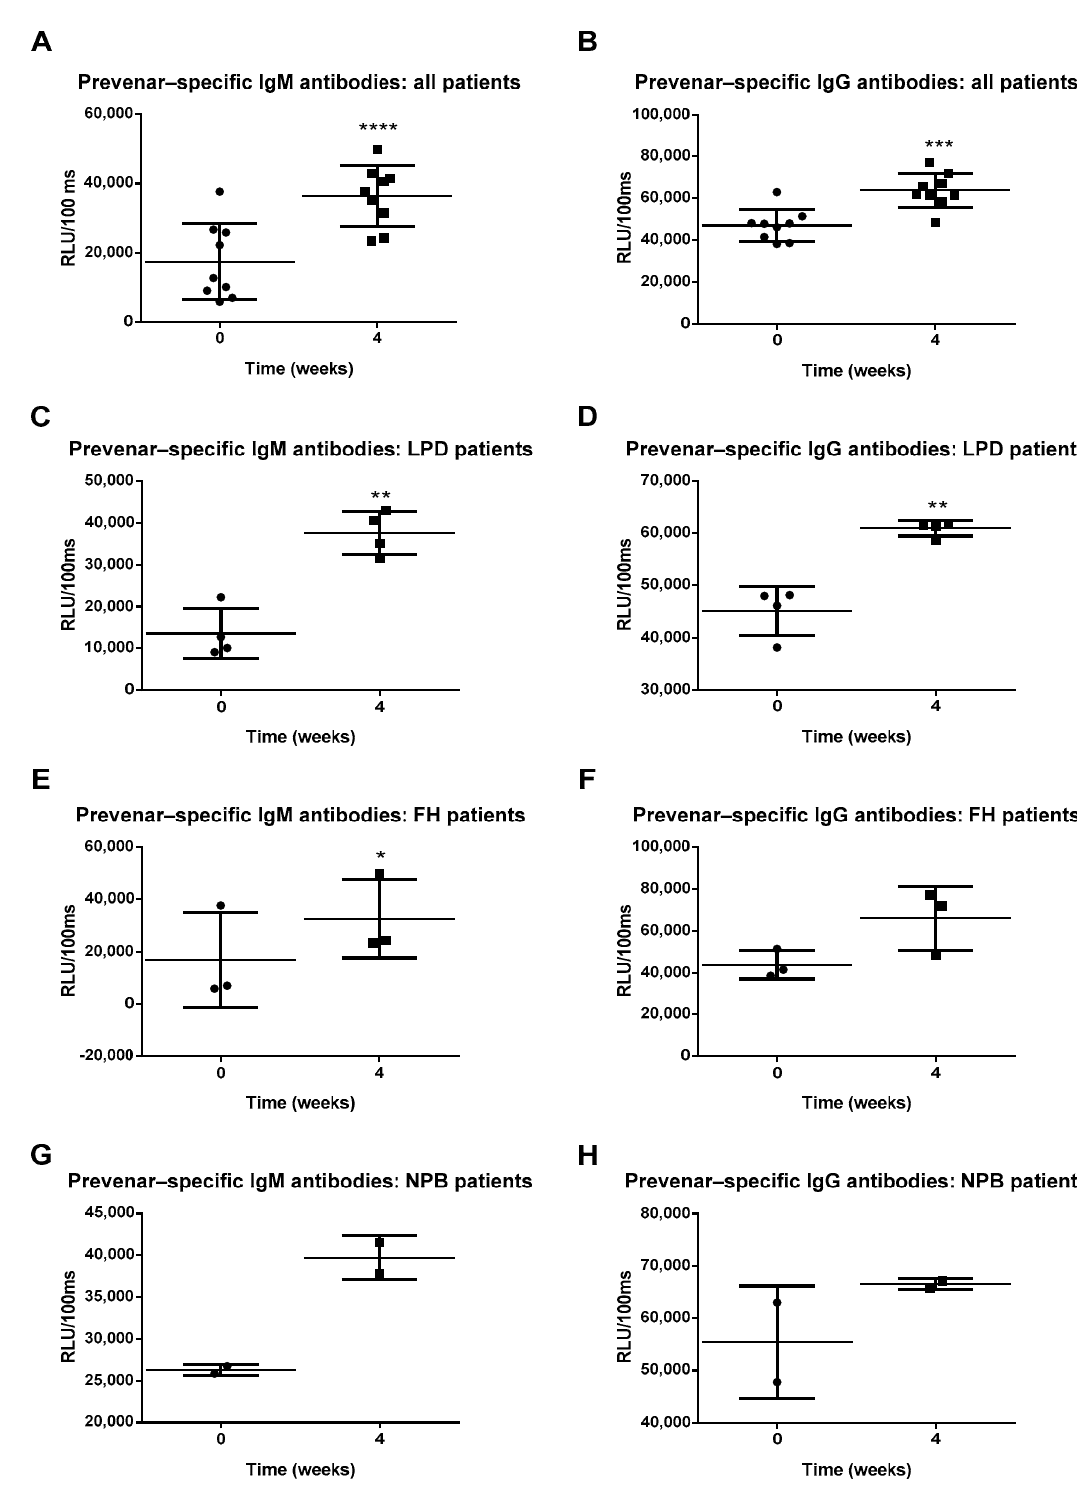
Figure 2. Prevenar-specific antibody titers. ( A , B ) Anti-Prevenar IgM and IgG antibody levels in all patients. ( C , D ) Anti-Prevenar IgM and IgG antibody levels in LPD patients. ( E , F ) Anti-Prevenar IgM and IgG antibody levels in FH patients. ( G , H ) Anti-Prevenar IgM and IgG antibody levels in NPB patients. * Indicates p < 0.05. All error bars represent SD.